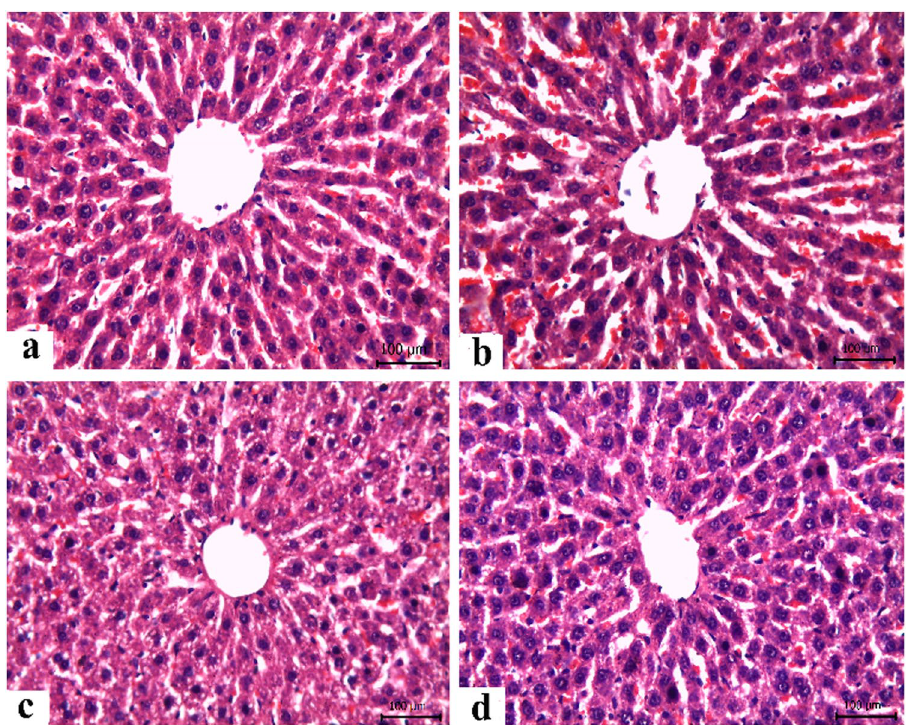
Figure 4. Histopathological findings. ( a ) Liver of control rat. ( b ) Liver of irradiated rat showing focal areas of degeneration, congested and dilated sinusoids. ( c ) Liver of a rat received dates syrup. ( d ) Liver of a rat pretreated with date syrup and exposed to radiation revealing slight congestion of